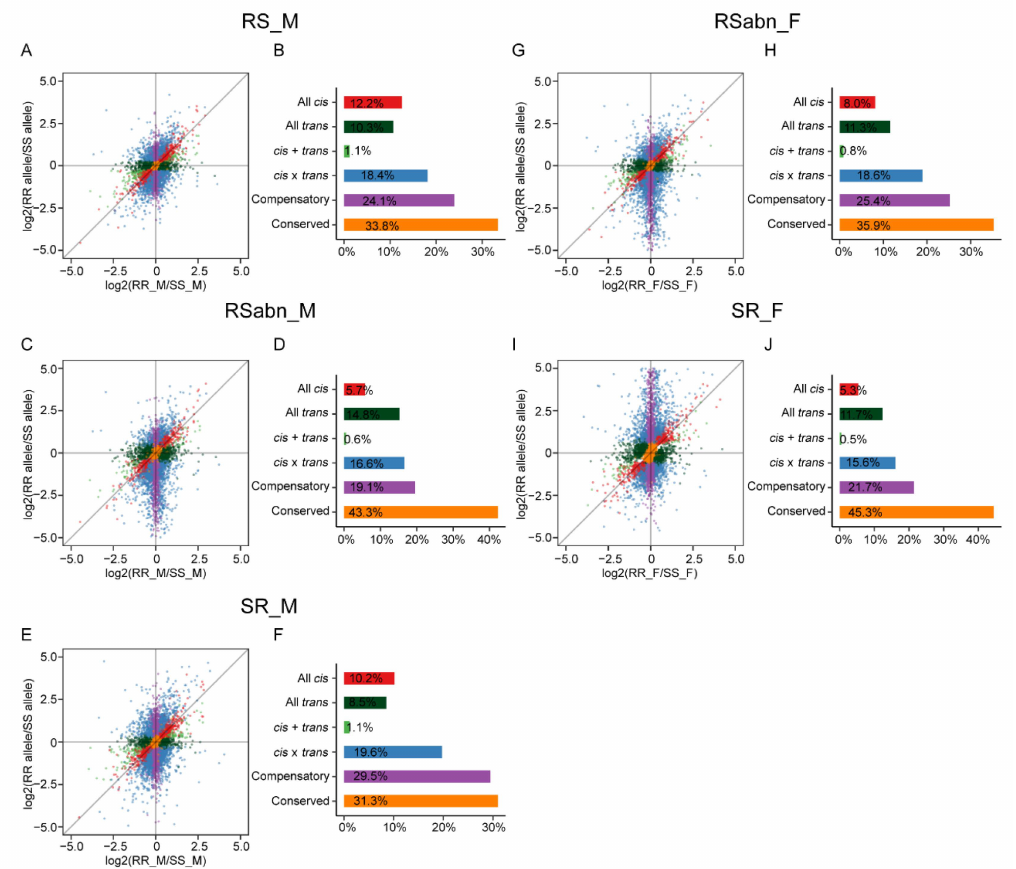
(Table S7) based on the outcomes of statistical tests following the criteria outlined by Coolon et al. [42]. In the five groups of F 1 hybrids, the proportions of genes classified as conserved were 31.3–45.3%, and those of compensatory were 19.1–29.5% (Figure 4), indicating that more than half of the genes that are classified into specific regulatory patterns have no dif- ference in expression between the antennae of H. armigera and H. assulta . Among the genes that were divergently expressed between the two parents, we found that the regulatory patterns of gene expression divergence in the male antennae of H. armigera and H. assulta are different from those in female antennae. The proportion of genes classified as all cis was higher than that of all trans in both RS_M and SR_M, while the proportion of genes classified as all trans was higher than that of all cis in SR_F, and the proportion of genes classified as all cis in both RS_M and SR_M was higher than that of SR_F (Figures 4A,B,E,F,I,J and S4D,E). These results indicate that the regulatory patterns of gene expression divergence in male antennae of H. armigera and H. assulta are different from those in female antennae, which could contribute to the differentiation of sexual dimorphism in antennae.